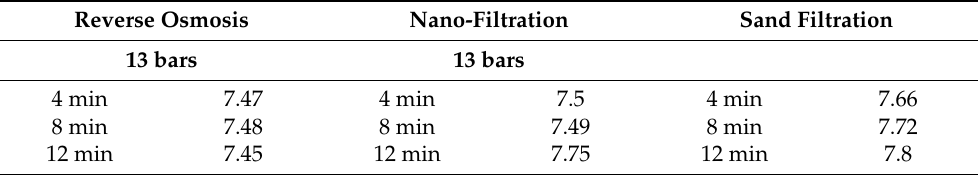
Table 4. pH Values for 12 min.